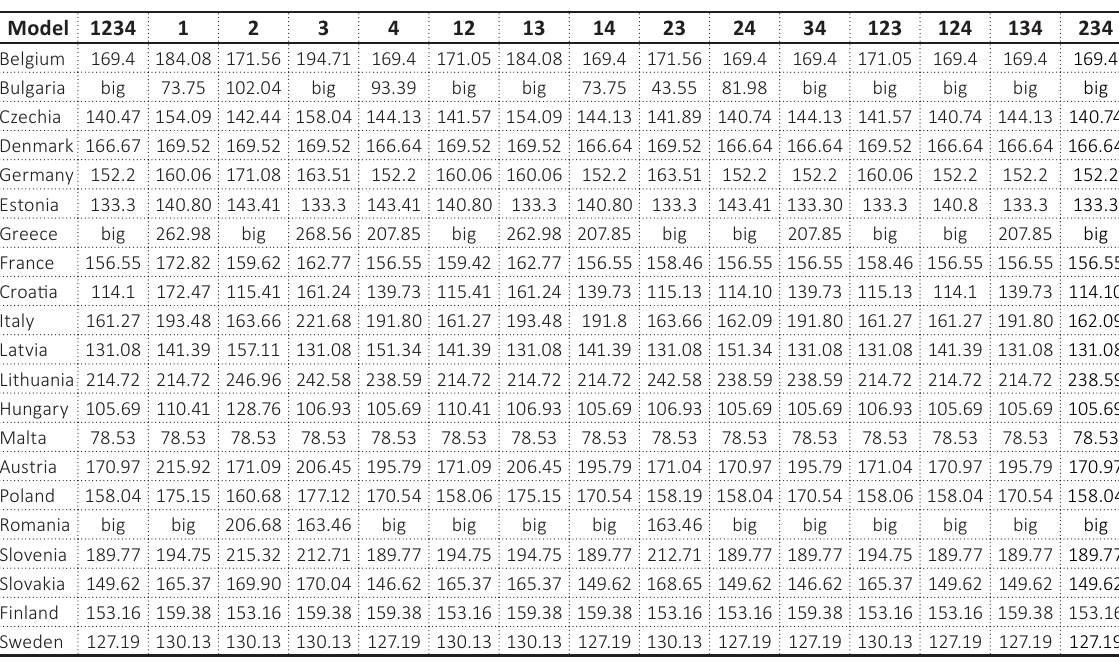
Table A1. Efficiency scores in fifteen output-oriented VRS models in 2018